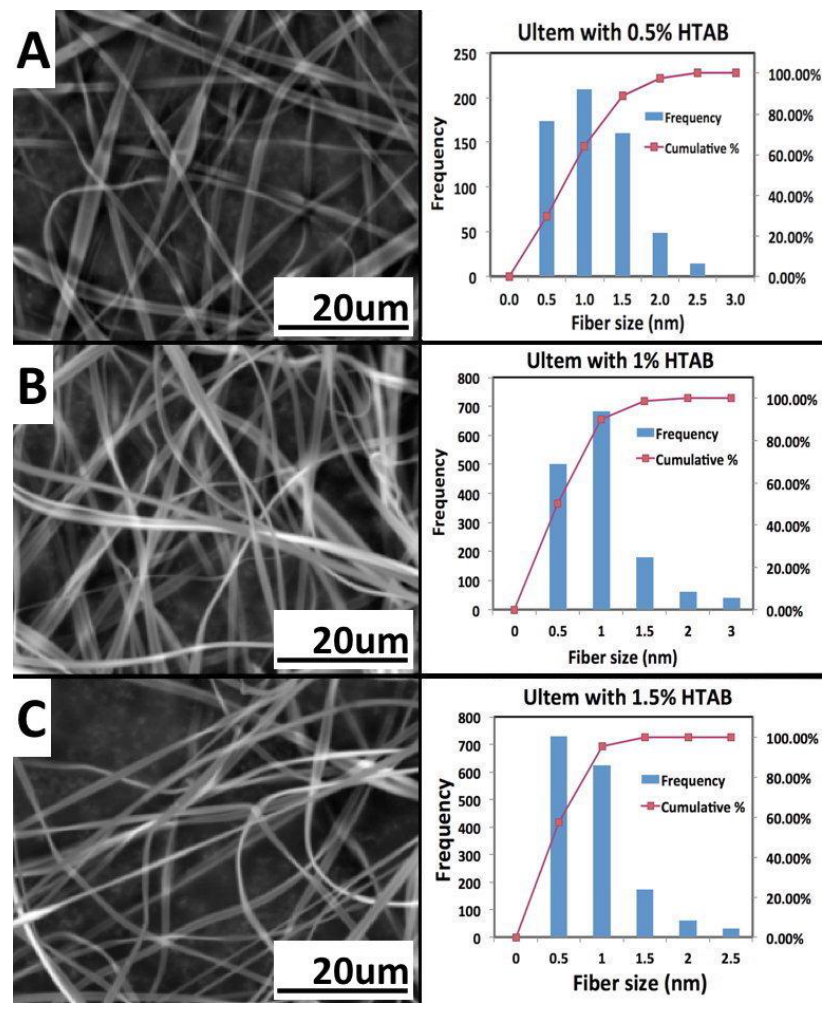
Figure 7. SEM images of 14 wt. % PEI and ( A ) 0.5 wt. % HTAB, ( B ) 1 wt. % HTAB, ( C ) 1.5 wt. % HTAB surfactant addition electrospun fibers at 20 kV/20 cm and 10 µ L/min.